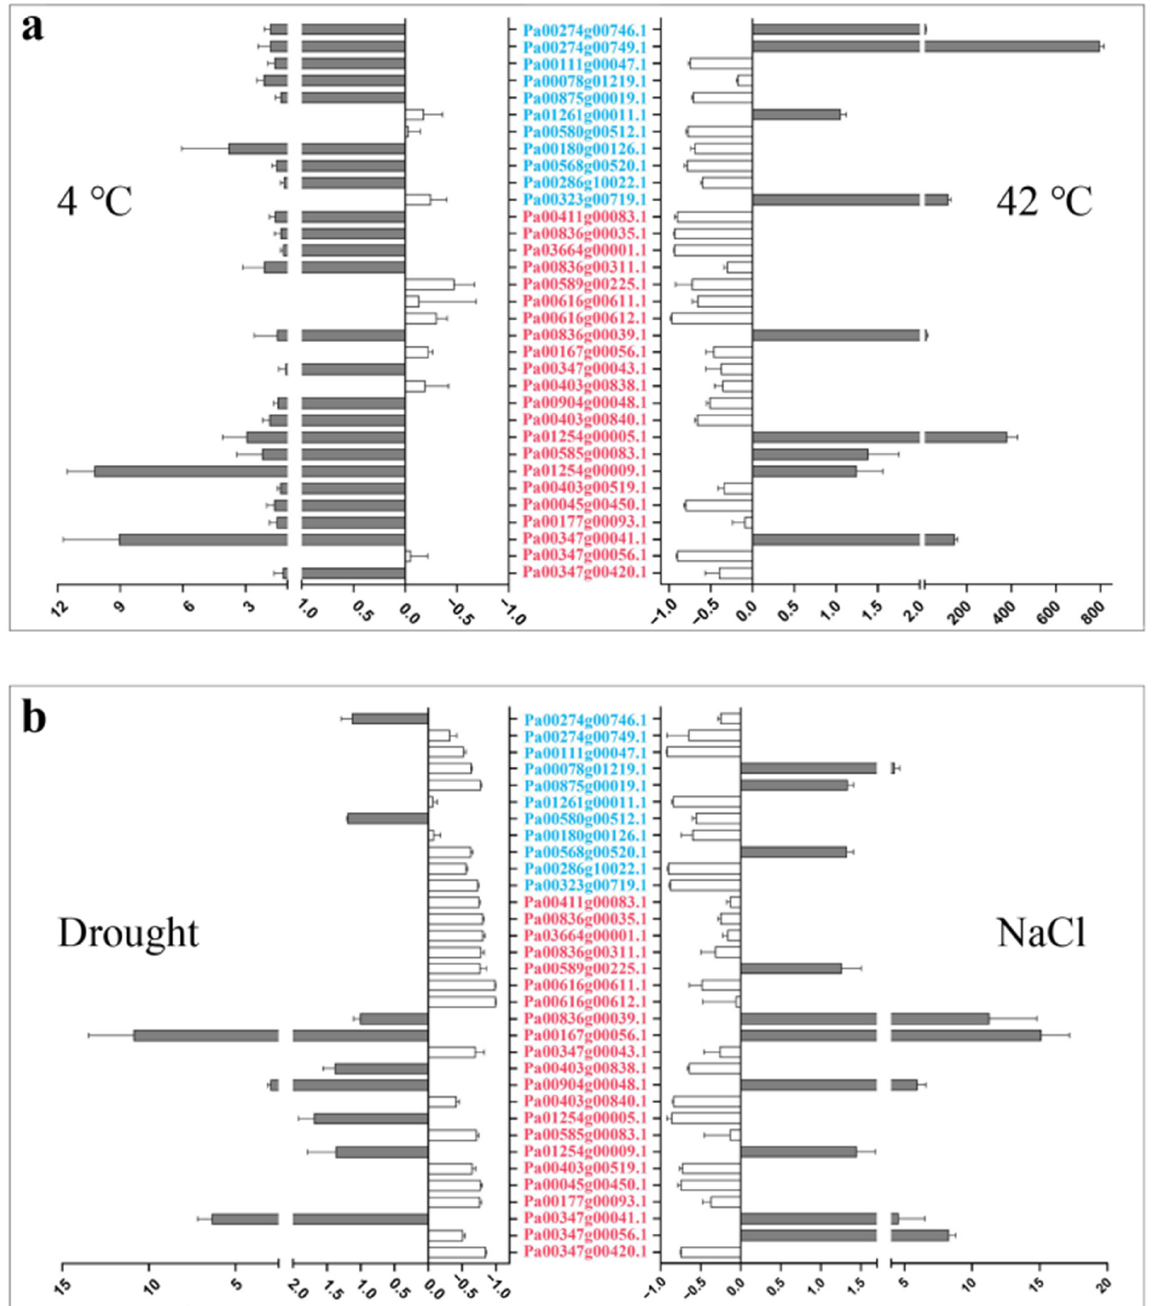
Figure 6. Relative expression patterns of PaCTLs under abiotic stress conditions. ( a ) Relative expres- sion patterns of the PaCTLs under low and high temperature stress. ( b ) Relative expression patterns of members of the PaCTLs under drought and salt stress. The abscissa value greater than 0 indicated the expression of PaCTL was up-regulated; The abscissa value less than 0 indicated the expression of PaCTL was down-regulated. The genes marked in blue were the members of the GH19 subgroup, and the genes marked in red were the members of the GH18 subgroup.